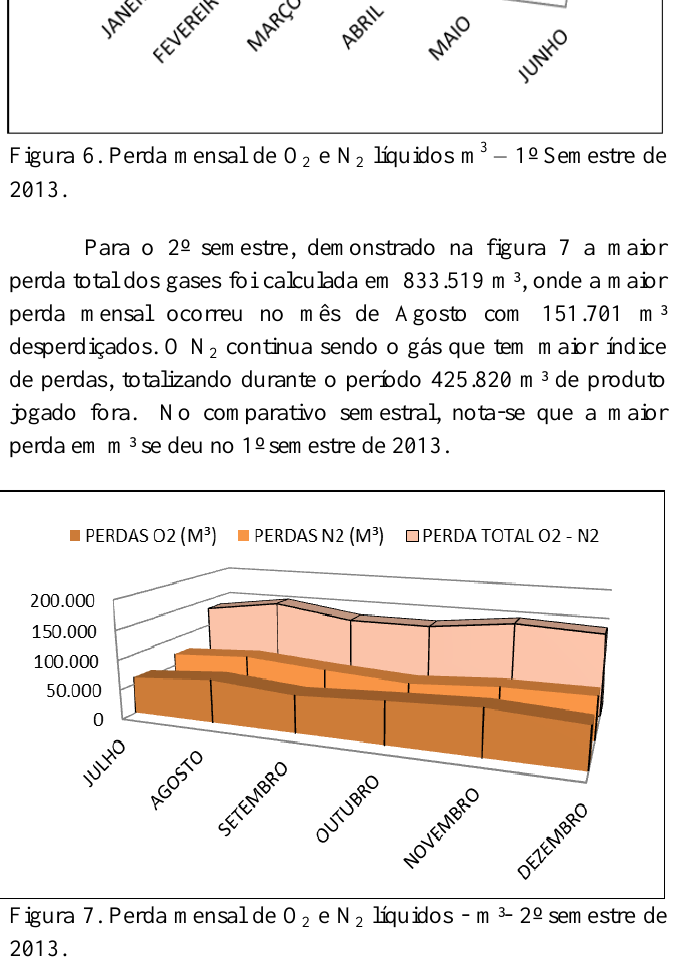
e N líquidos (R$) 1º semestre 2 2